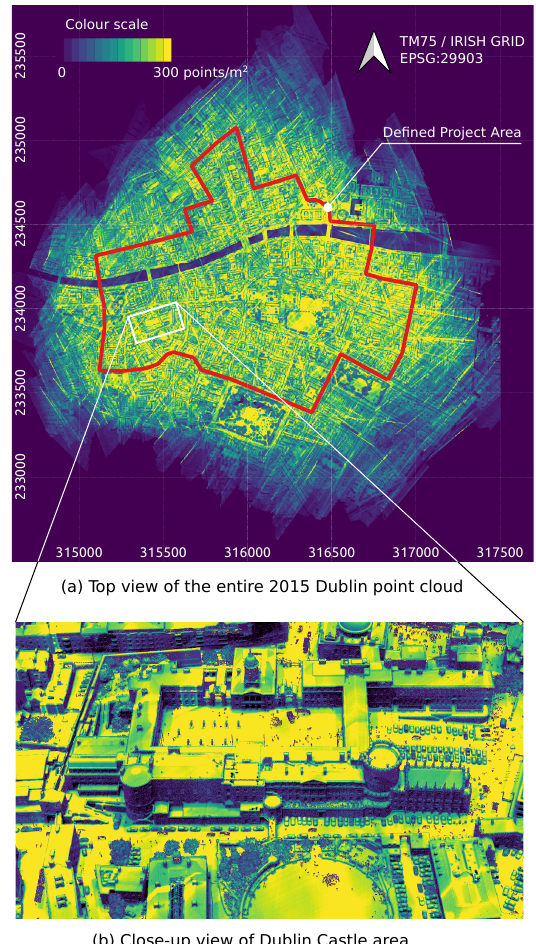
Figure 3. Local point density index result; the areas in yellow exceed 300 points/m 2 ; the dark blue on the building facade is typically 30 points/m 2 The blue and dotted, orange histograms in Figure 4 represents the point density distributions in the BPA and the DPA, respect- ively. The proportion of lower density points in the BPA is higher than that in the DPA because the BPA includes partially covered areas. Each histogram has two peaks. The higher peak (around 280 points/m 2 ) represents the typical point density on horizontal surfaces such as the ground and building rooftops.